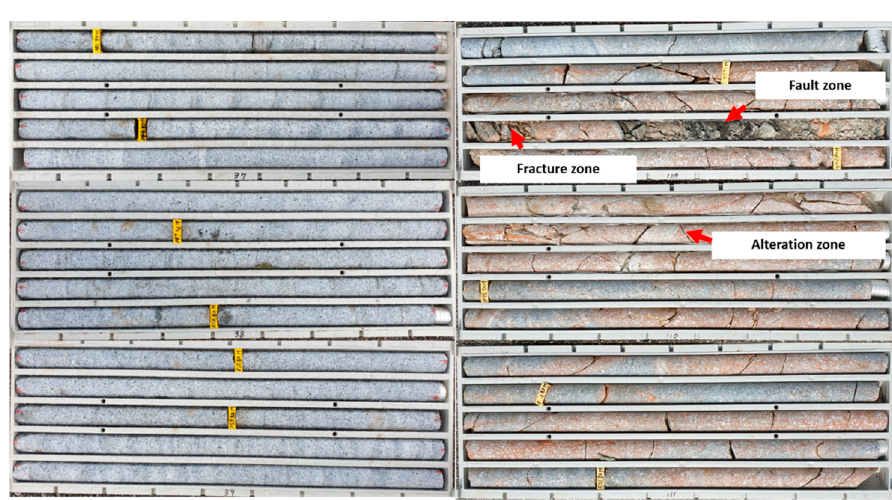
Figure 7. Core samples of the study area.